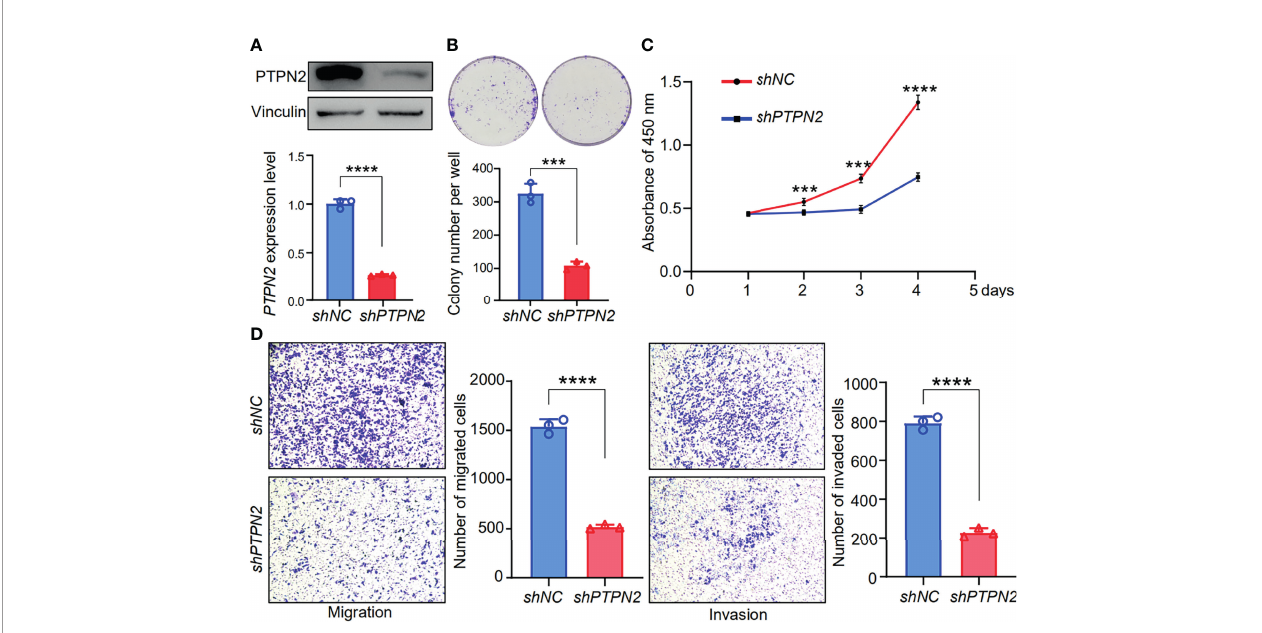
FIGURE 7 | Functional analysis of PTPN2 knock down in pancreatic adenocarcinoma cells. (A) The protein levels of PTPN2 were detected by RT-qPCR and western blot analysis in shPTPN2 or vector-transfected PANC-1 cells. vinculin was used as an endogenous control. (B, C and D) Effects of knock-down of PTPN2 on the colony formation (B) , cell growth (C) , migration and invasion (D) in PANC-1 cell lines. ***p < 0.001, ****p <